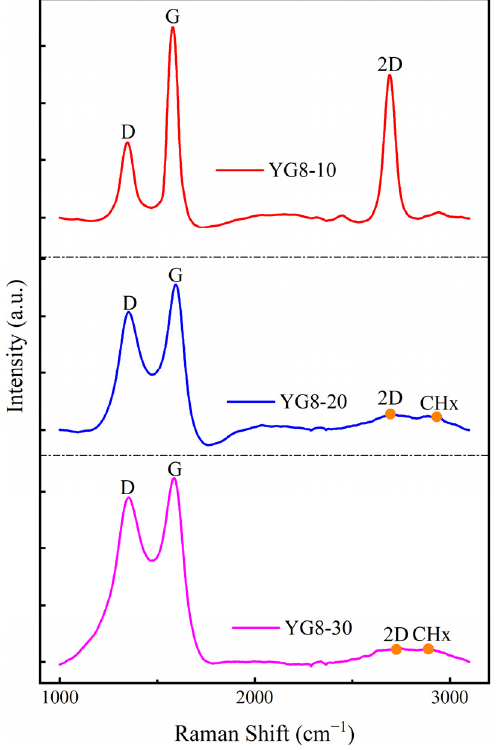
Figure 7. The Raman spectra at different methane flows.